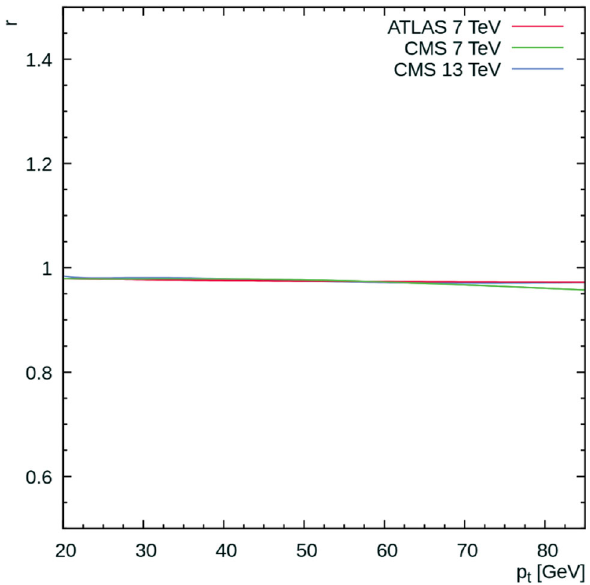
Fig. 1 The production ratio r ( p t ) calculated as a function of ϒ( 2 S ) transverse momentum p T in the different kinematical